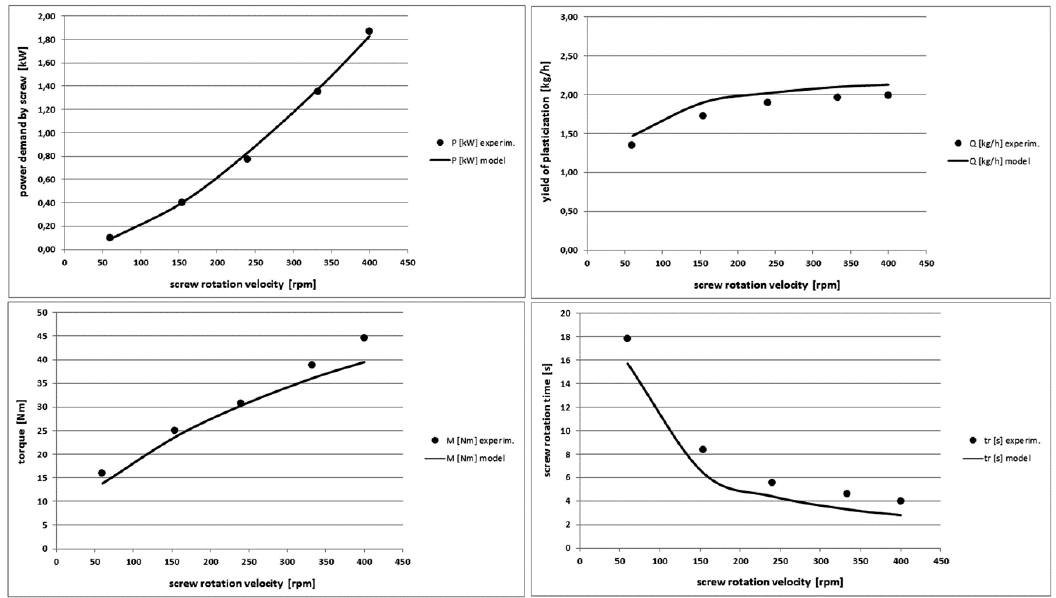
Figure 17. Comparison of other theoretical and experimental characteristics for different screw rotation velocity and back pressure values in PP injection process.